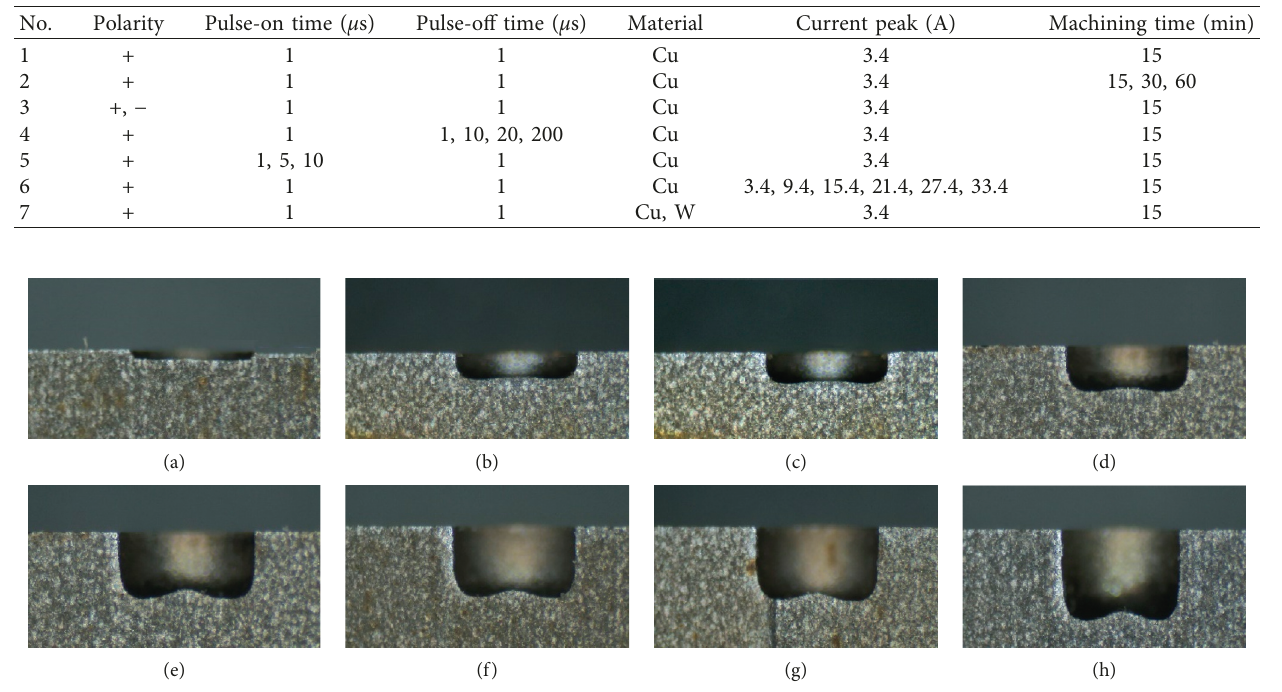
Figure 1: Shape changes of the holes over time (no.1 of Table 1). (a) 1min. (b) 3min. (c) 5 min. (d) 7 min. (e) 9 min. (f) 11min. (g) 13min. (h) 15